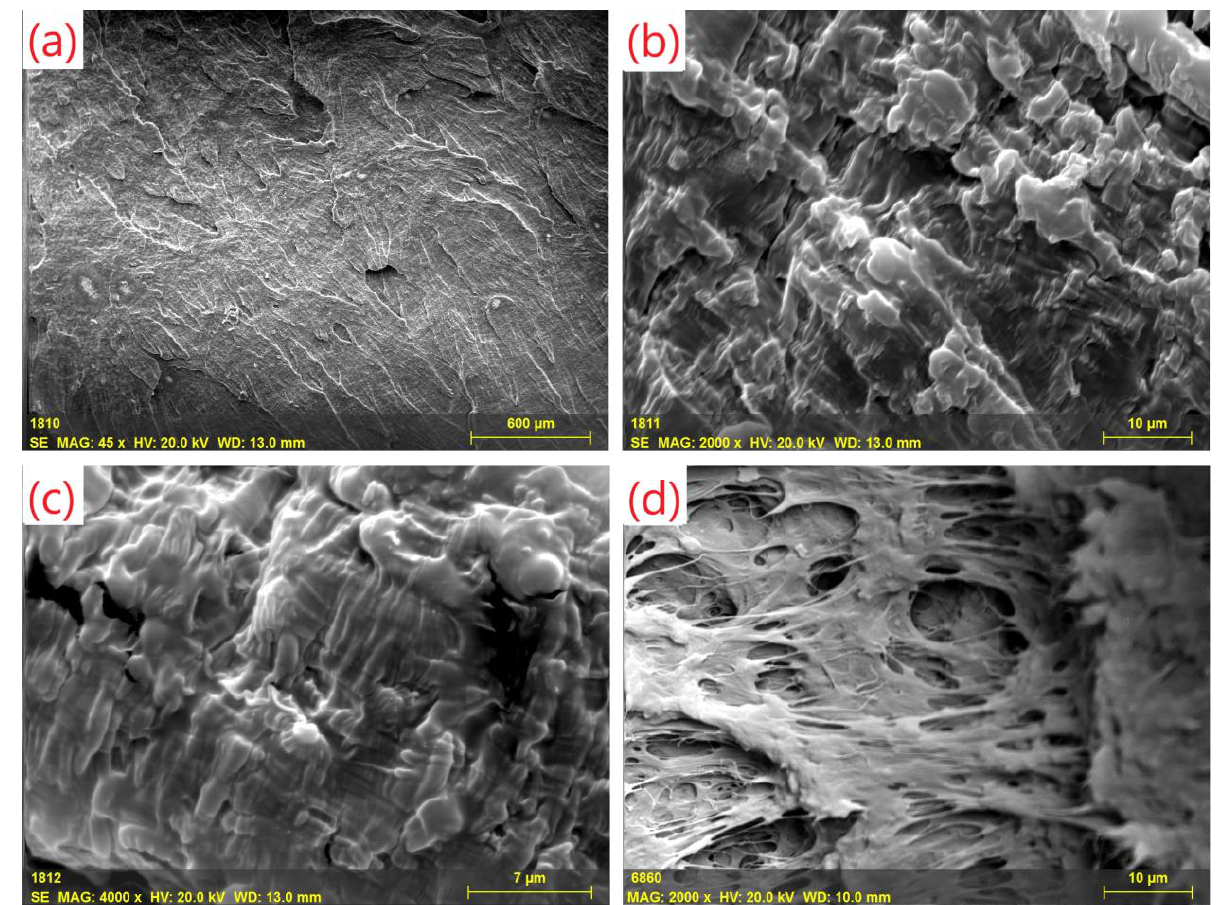
Figure 2. SEM images of ( a ) PP polymer, ( b , c ) 0.5 wt% filled PP/MWCNT nanocomposites, ( d ) PP masterbatch. Table 1. Results of mechanical properties (tensile) of PP and PP/MWCNT nanocomposites (negative changes highlighted in red, positive changes in